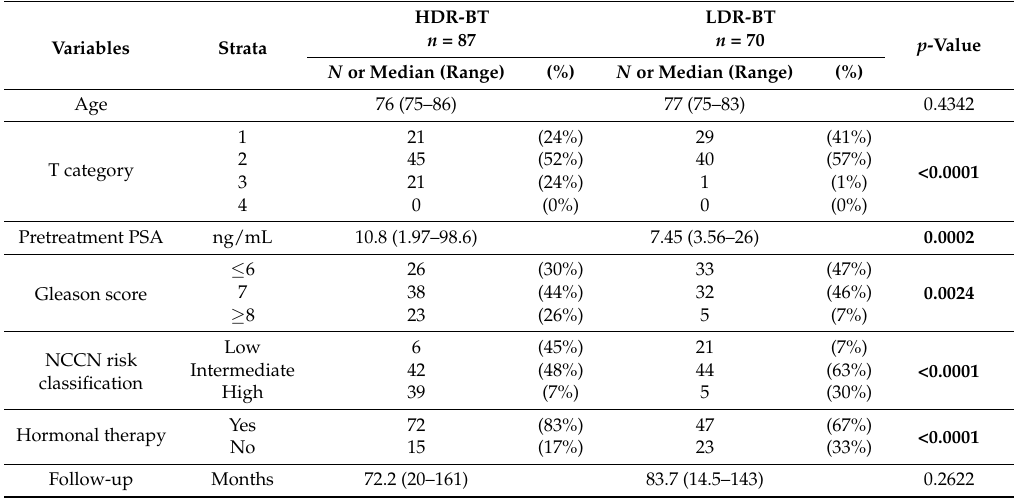
Table 5. Characteristics and treatment factors of elderly patients between HDR-BT and